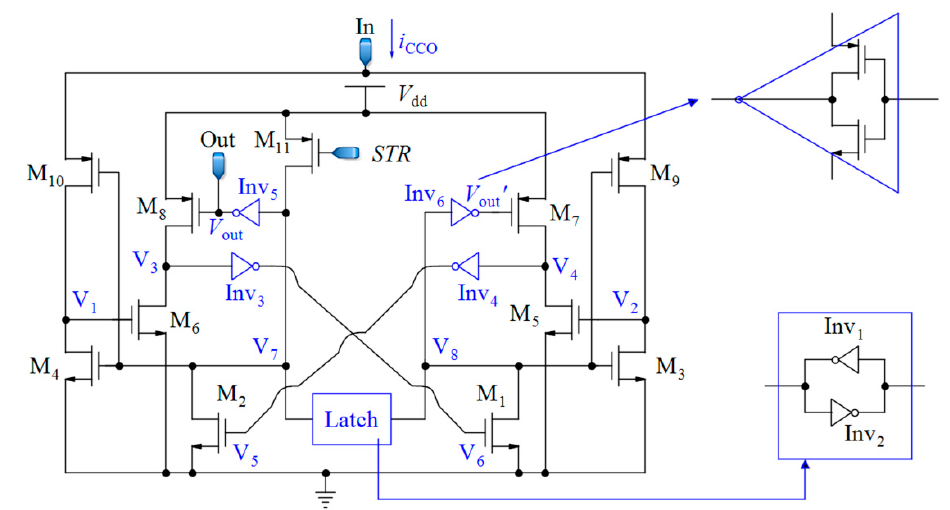
Figure 10. Complete current-controlled oscillator proposed in [75].